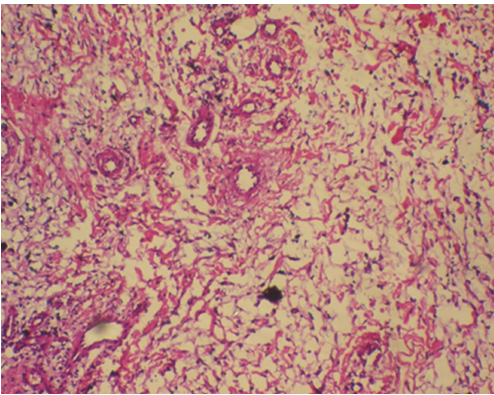
Figure 1: Di ff use, reddish, and slightly ulcerated lesion in the right alveolar region.